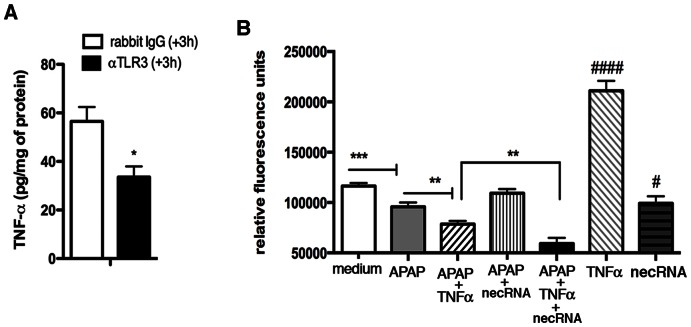
TLR3 activation leads to TNFα generation, which synergizes with TLR3-mediated effects in hepatocytes.(A) TNFα protein levels were measured in fasted WT mice that received either control rabbit IgG or anti-TLR3 mAb at 3 h after APAP injection (300 mg/kg; i.p. injection). The data represent mean ± SEM from 2 independent experiments (n = 5 per group/experiment). *p<0.05; when IgG treated group was compared with anti-TLR3 antibody treatment. (B) 2.0×104 mouse WT primary hepatocytes were plated in 96-well tissue culture plates and treated with APAP with or without TNFα and/or necrotic RNA. In separate wells, the cells were stimulated only with medium, TNFα or necrotic RNA (no APAP). After 24 h, Presto Blue was added to the cultures and incubated at 37°C, 5% CO2. After 1 h, the plates were read for a fluorescence signal that represents viable cells (n = 12 for each stimulus). ***p<0.001 when medium was compared with APAP; **p<0.01; when APAP alone or APAP+TNFα was compared with APAP+TNFα+necrotic RNA. #p<0.05 when necrotic RNA was compared with medium; ####p<0.0001 when TNFα was compared with medium.